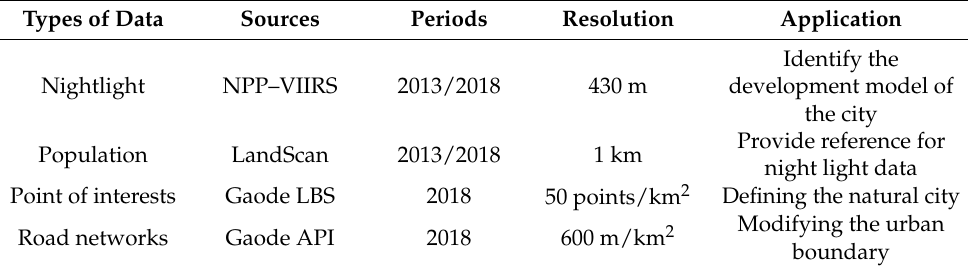
Table 2. Basic information and main applications of urban multi-source